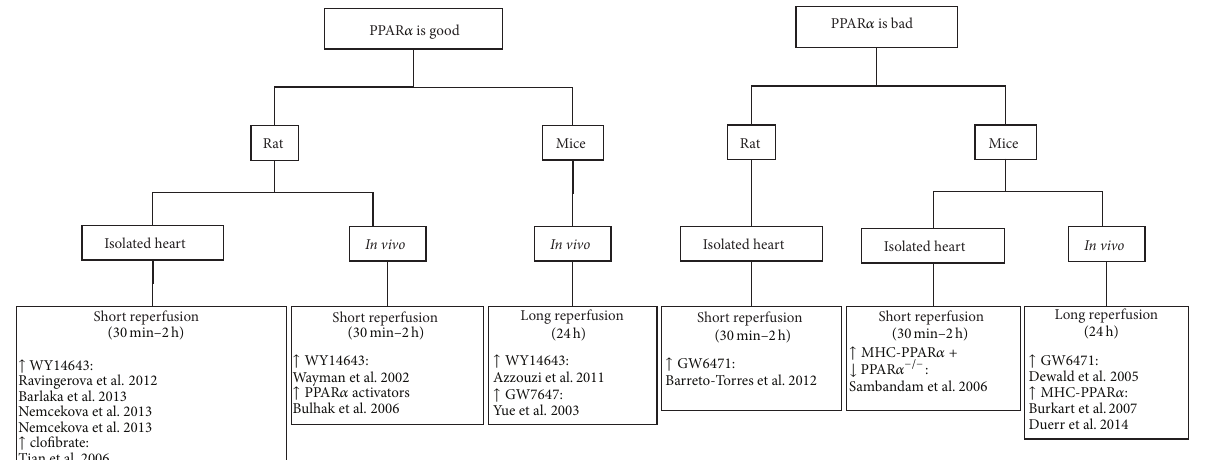
Figure 3: Effect of PPAR 𝛼 activation on cardiac function after I/R. The role of peroxisome proliferator-activated receptor (PPAR) 𝛼 activation in I/R injury is unclear as both beneficial and detrimental effects have been reported depending on the experimental model and timing of